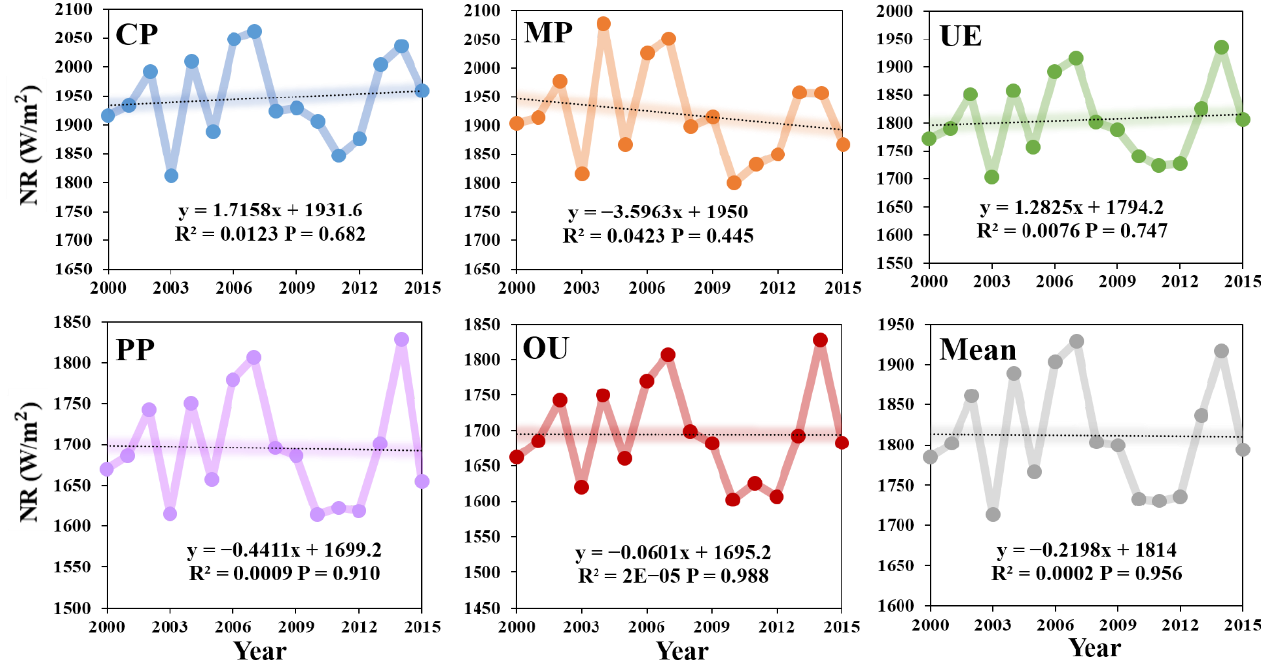
Figure 7. Net radiation (NR) trend of different land use types in the Huang-Huai-Hai River Basin from 2000 to 2015.